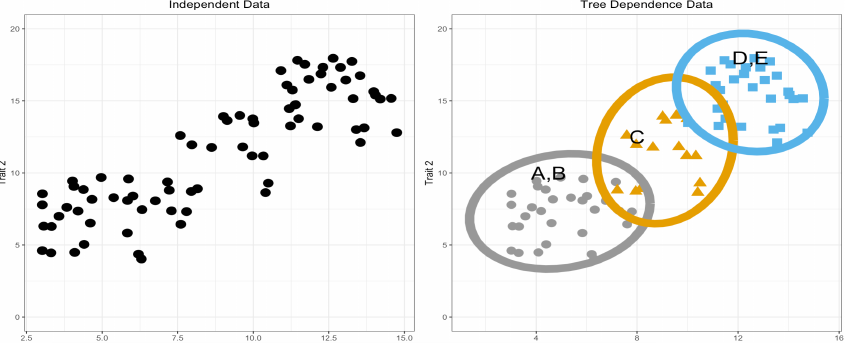
Figure 2. Scatter plots for a pair of hypothetical traits of the five species. Left panel : bivariate com- parative data, assuming independence without phylogenetic relationships. Right panel : bivariate comparative data categorized by the species A , B , C , D , E assuming the relationships adapted from Figure